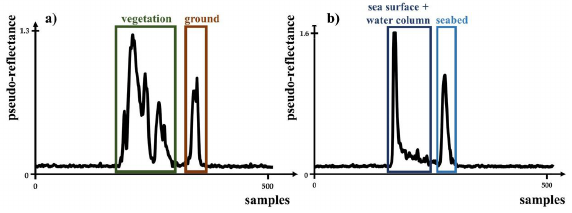
Figure 1. Typical example of a) a bathymetric waveform and b) a topographic waveform.